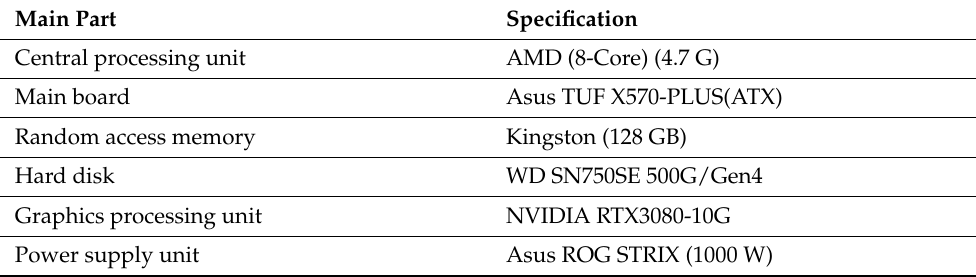
Table 5. Description of the experimental